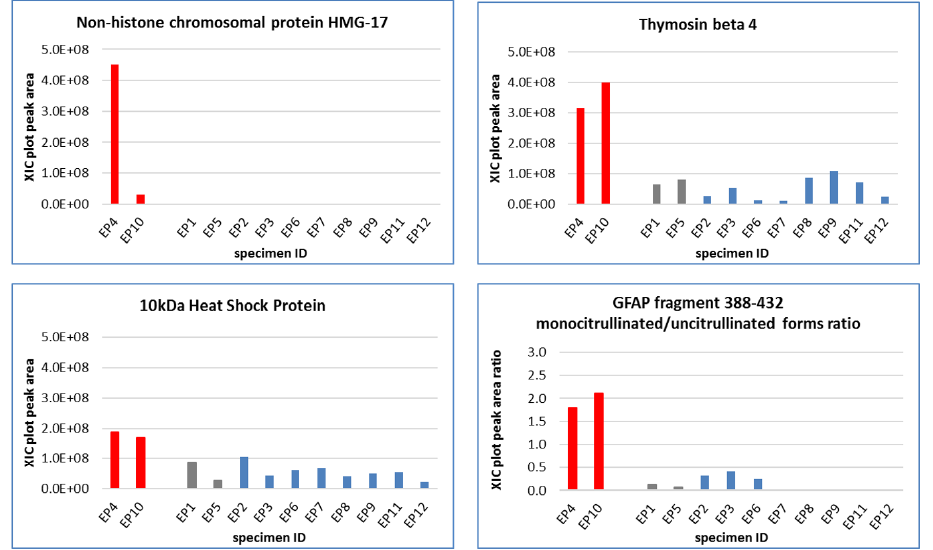
Figure 3. Proteins with statistically significant level variations between supratentorial (ST) and posterior fossa (PF)-EPs.